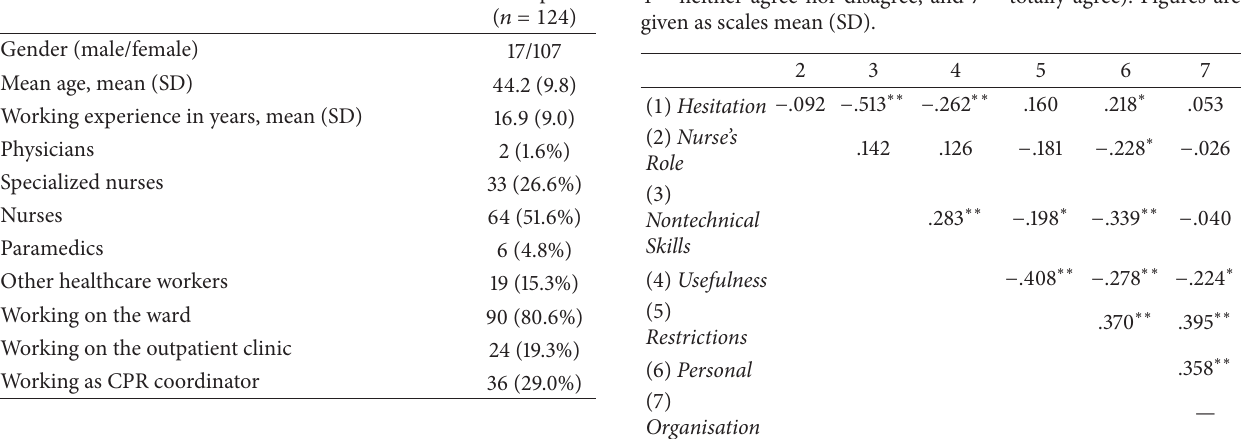
Table 3: Background data of the respondents. A questionnaire was distributed to CPR trainers attending two seminars. Figures are presented as numbers or as percentage.